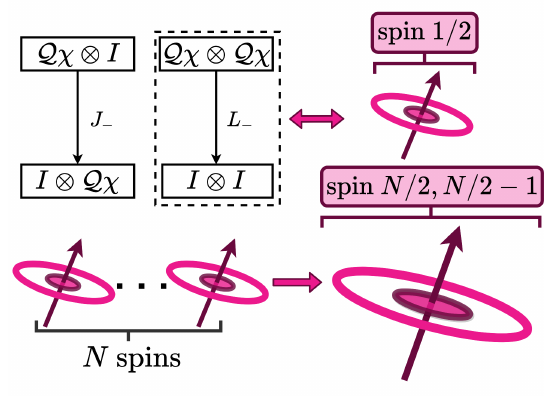
Figure 2 . The four local operator-states form two doublets of the emergent SU(2) ⊗ SU(2) algebra. The J doublets do not contribute to the OTOC because they have odd local parity. The operator dynamics of N Majoranas are mapped to the imaginary time dynamics of N 1/2-spins from the L doublets, which compose to form N/ 2 and N/ 2 − 1 spins of the global SU(2) algebra generated by ~L in eq. (4.7). The largest Hilbert space dimension is N + 1 . There is a single irrep with largest angular momentum L = N/ 2 , ( N − 1) irreps